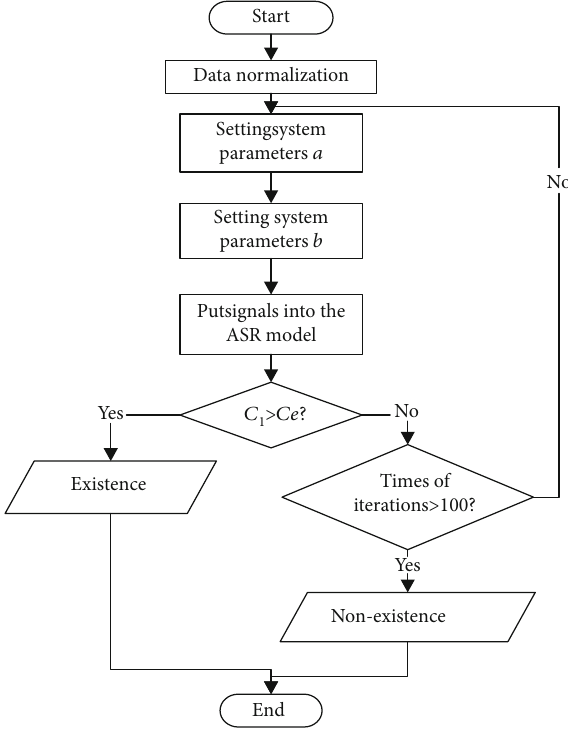
Figure 10: The fl ow chart of the algorithm for weak particle signal based on